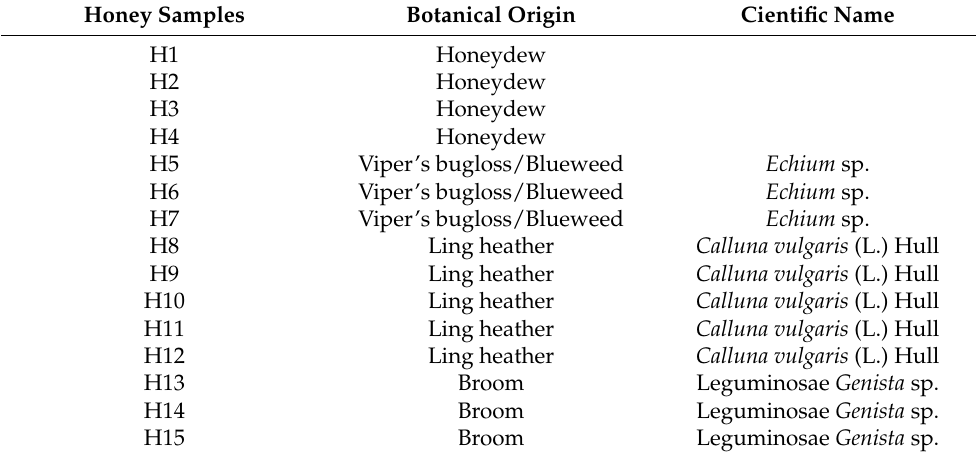
Table 1. Botanical origin of the honey samples. Honey